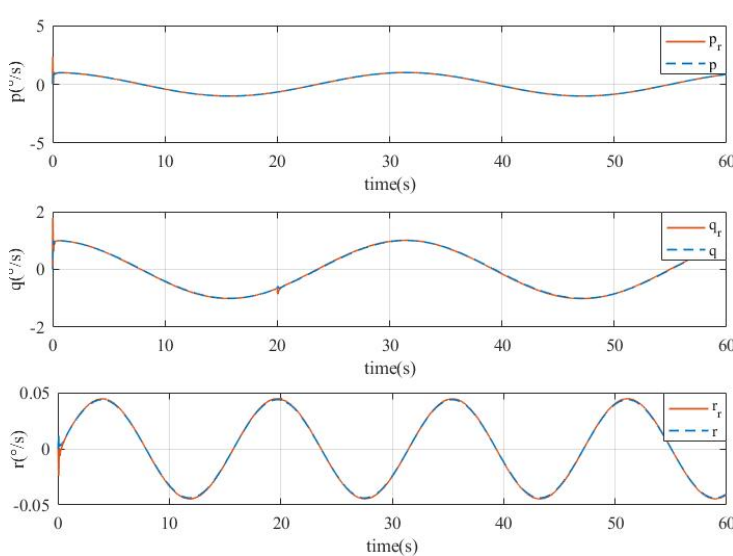
Figure 13. Deflections of the elevons and elevators.